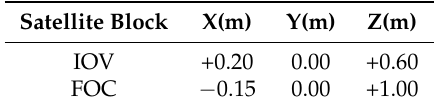
Table 3. Antenna offsets for CoM correction of broadcast ephemeris